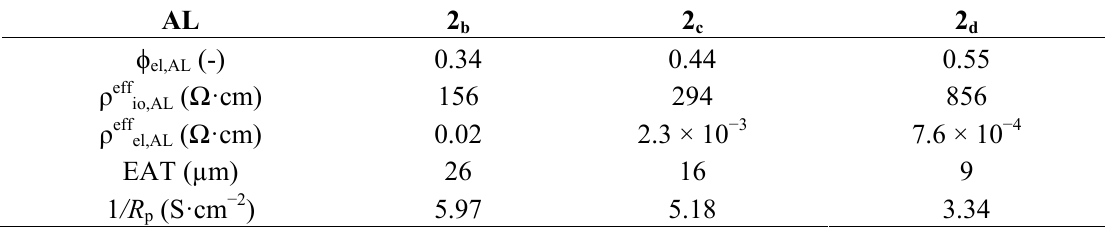
Table 3. Simulated 1 /R , electrochemically active thickness (EAT) and effective electronic p and ionic resistivities of the AL, for three different Ni-YSZ compositions, at 1073